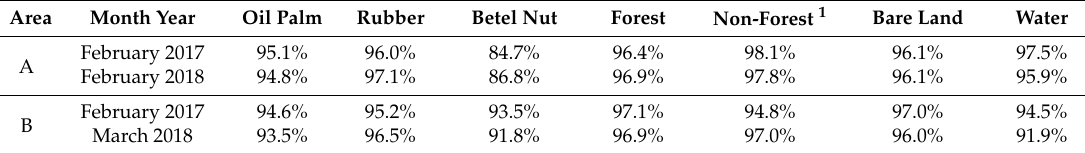
Table 7. Median user’s accuracy per class across the four images.